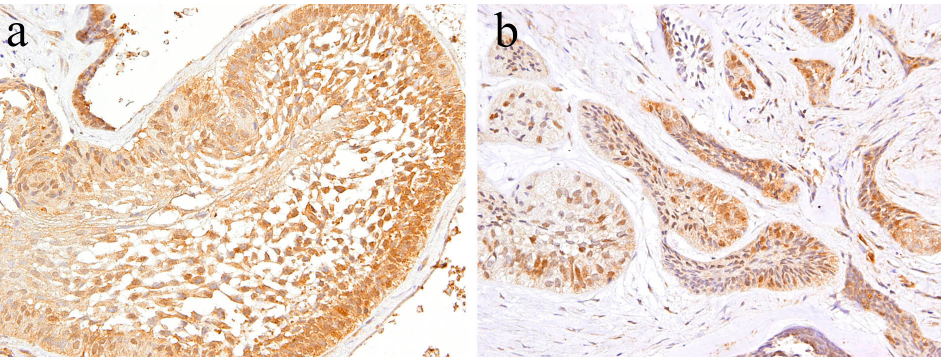
Figure 2. Immunohistochemical features of Notch1 in ameloblastoma. ( a ) Notch-positive reactions are observed in the cytoplasm of peripheral columnar cells and central squamous metaplastic cells. Magnification × 100. ( b ) Notch-positive reactions in the budding and peripheral layer of the epithelial nests. Magnification × 100. Anti-Notch-1 intracellular domain antibody, Abcam, ab83232,